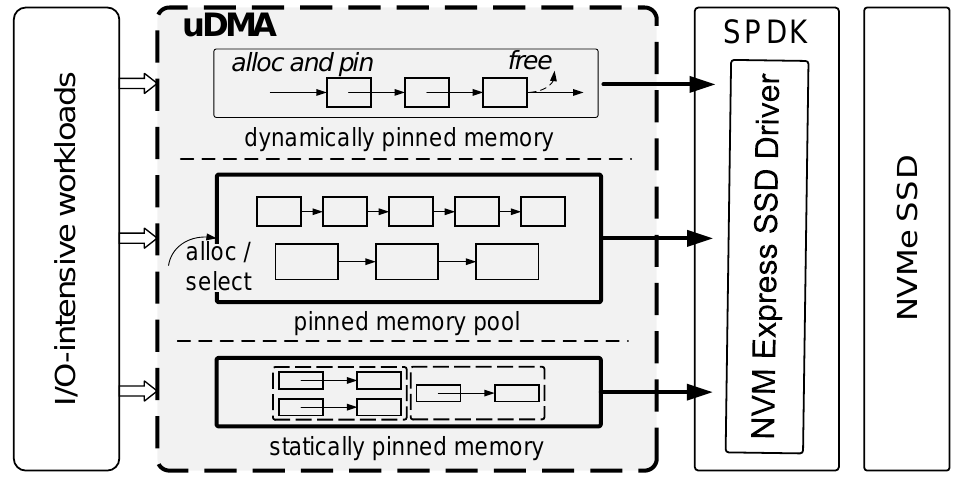
Figure 2. The framework of